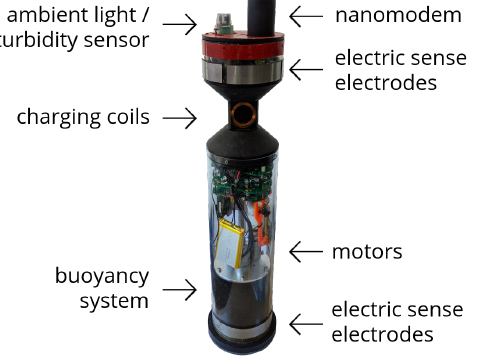
Figure 2. The aMussel robot—sensors, actuators and communication